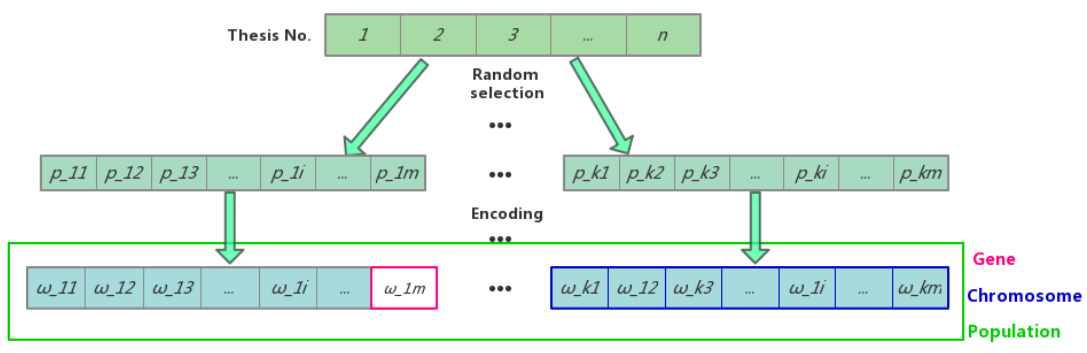
Figure 3. Initialization and